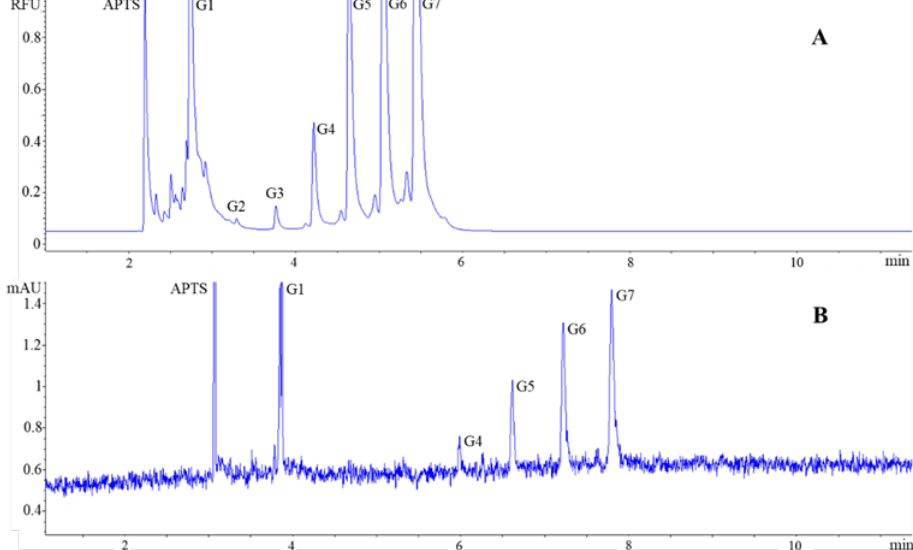
Figure 1. The CZE electropherograms of an APTS-labeled malto-oligosaccharide ladder standard using LEDIF ( A ) and UV ( B ) detection. The GX numbers indicate the numbers of glucose residues of the ladder. Conditions: fused silica capillary, l tot : 50 cm × 50 µm id, l eff : 30 cm ( A ), 42 cm ( B ), BGE: 25 mM ammonium acetate (pH 4.5), separation voltage: −30 kV, injection: 50 mbar × 2 s, preconditioning: 1 M HCl for 5 min, BGE for 5 min washing. LEDIF detection was performed at 480 nm excitation/520 nm emission, UV detection was performed at 240 nm.